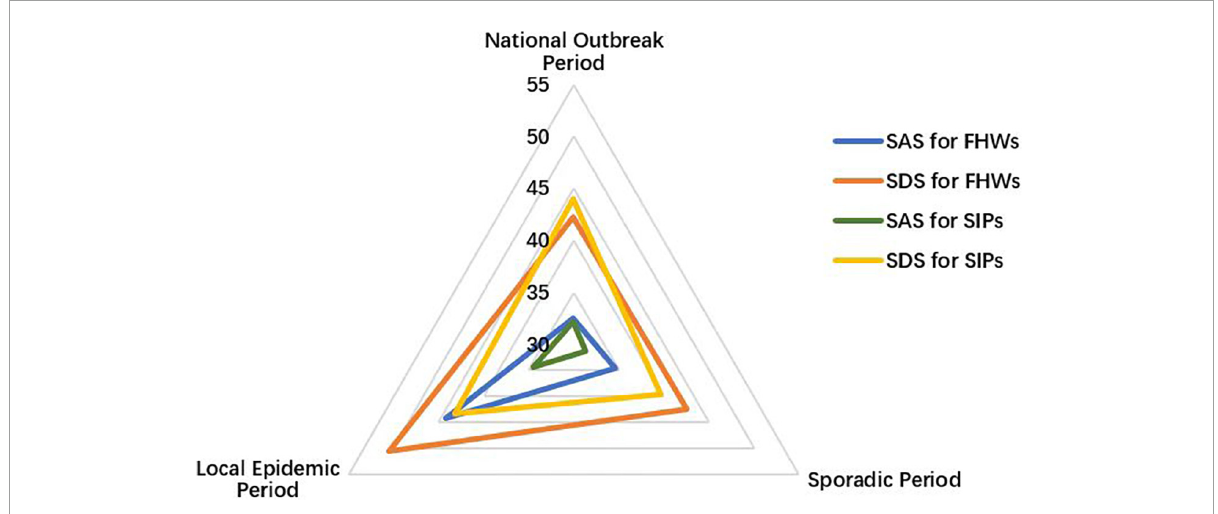
FIGURE4 The SAS and SDS scores for frontline health care workers (FHWs) and suspected infected patients (SIPs). SAS , the Zung Self-Rating Anxiety Scale; SDS , the Zung Self-Rating Depression Scale.